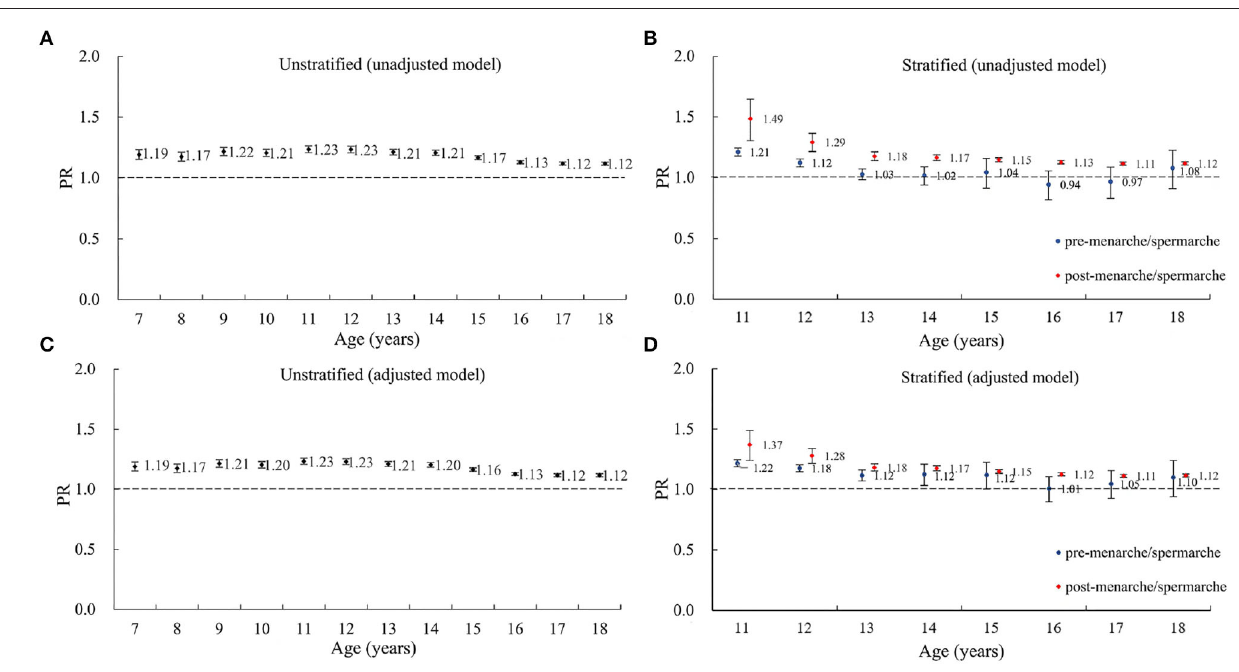
FIGURE 3 | The sex disparity in myopia prevalence estimated by regression models among boys and girls aged 7–18 in the 1995, 2000, 2005, 2010, and 2014 CNSSCH, stratified or unstratified by puberty status. (A) Unstratified (unadjusted model). (B) Stratified (unadjusted model). (C) Unstratified (adjusted model), (D) Stratified (adjusted model). PR, prevalence ratio, represents the relative risk of myopia for girls compared to boys. CNSSCH, Chinese National Survey on Students’ Constitute and Health. The unadjusted model only adjusted for the cluster effect of school. The adjusted model additionally adjusted for survey year, urban–rural location, regional socioeconomic status (SES) within province, and provincial GDP per capita. The error bars represent 95% confidence intervals